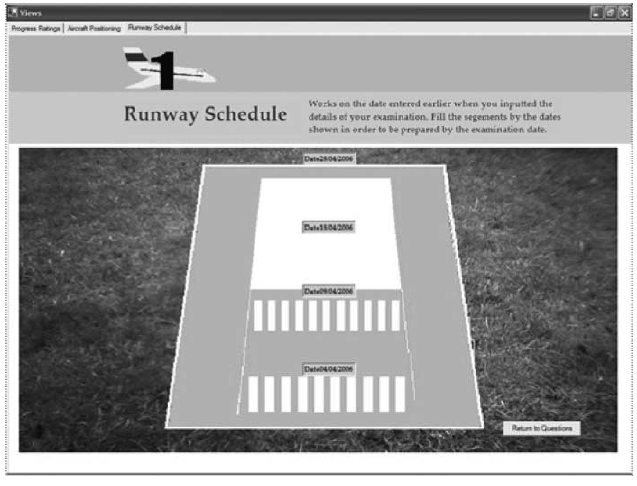
Figure 5. The runway schedule